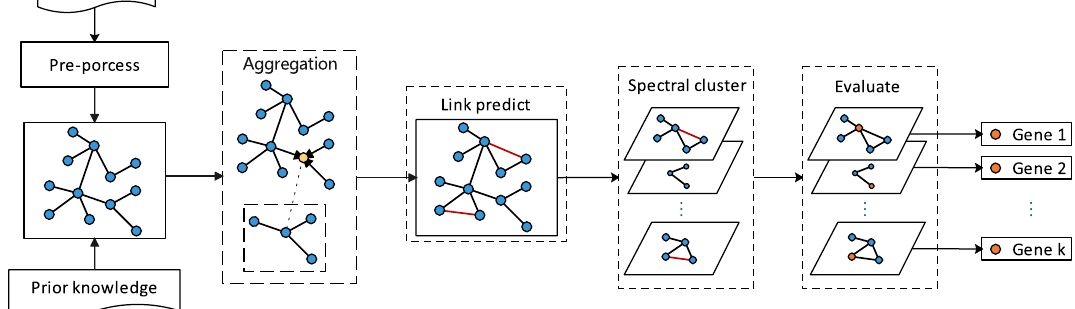
Figure 1. The flow of our proposed method. The aggregation process takes the first-order neighborhood of orange node as an